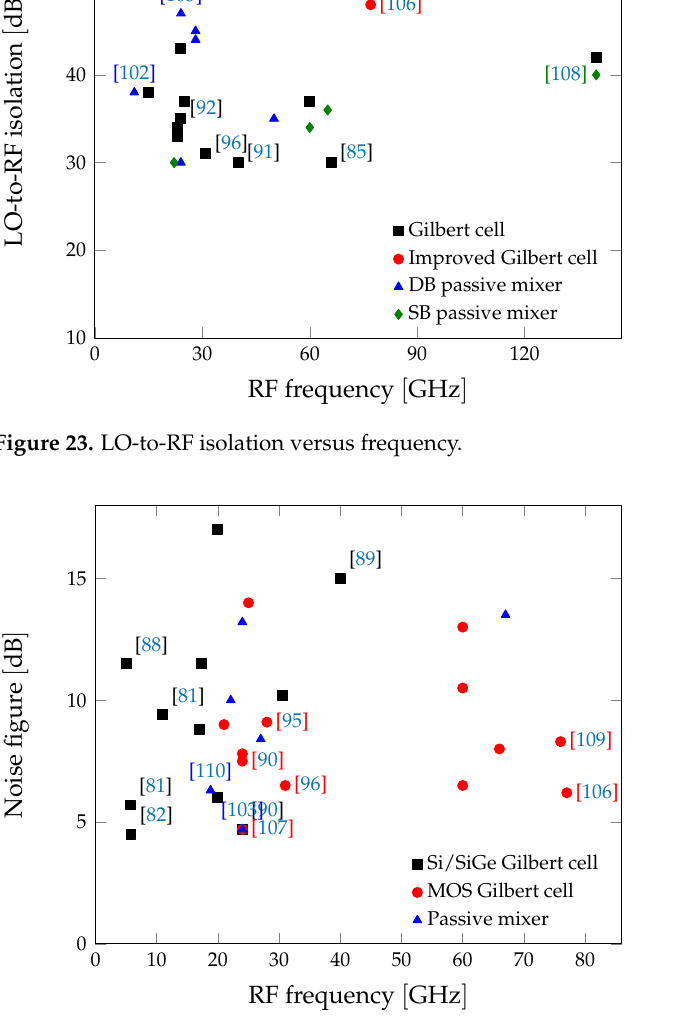
Figure 24. Double-sideband (DSB) NF plotted versus frequency for main type of